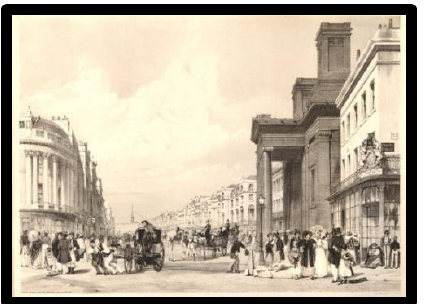
Figure 8: Boys, TS (1842) Regent Street, Quadrant . (URL 5)